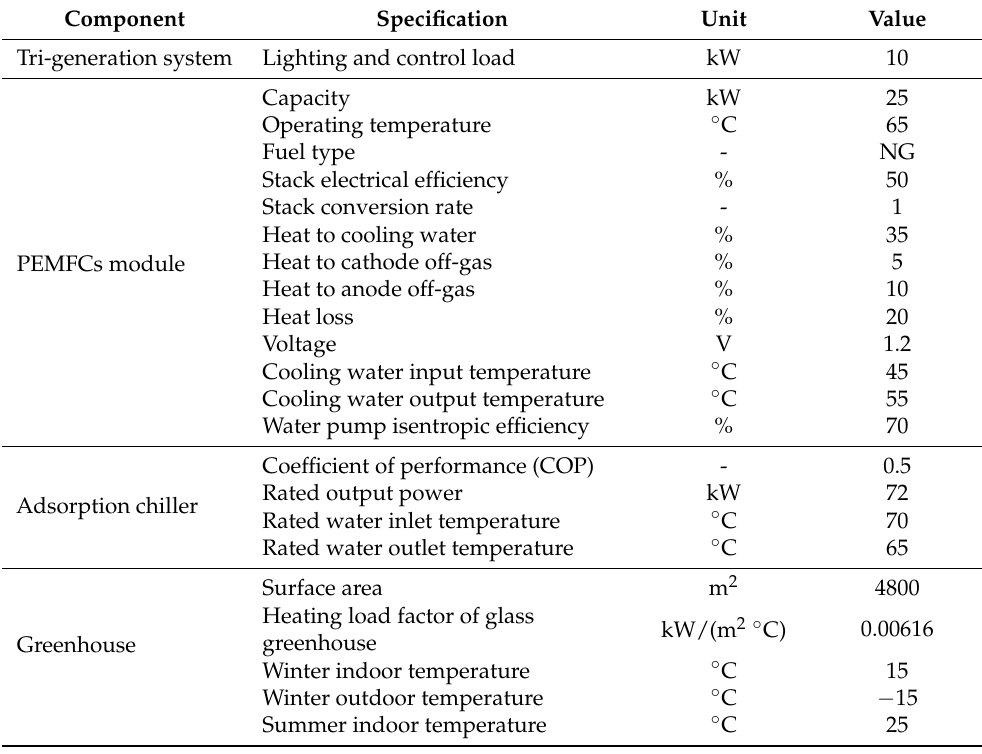
Table 2. Assumptions and specifications for system